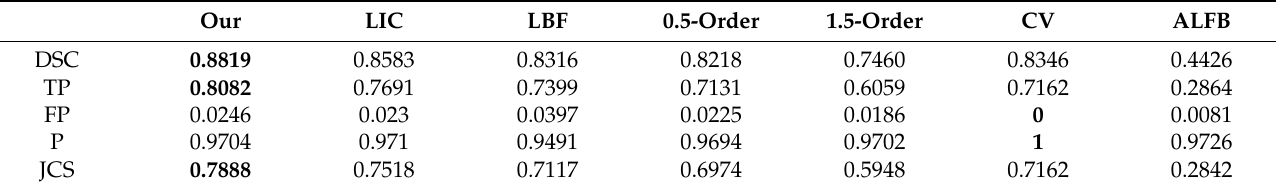
Table 3. The corresponding evaluation index values of Figure